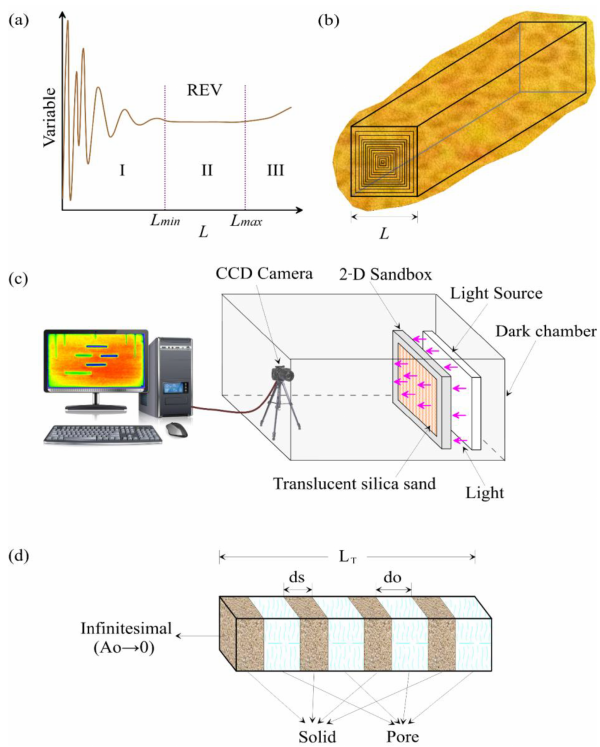
Figure 1. (a) Variable changes as a measured scale ( L ) increment in the conceptual curve (Costanza-Robinson et al., 2011); (b) scale effect and the cuboid image window geometry; (c) system device for acquisition of parameters (porosity and density, etc.) of translu- cent material; (d) the infinitesimal selected from translucent porous media packed in a 2D